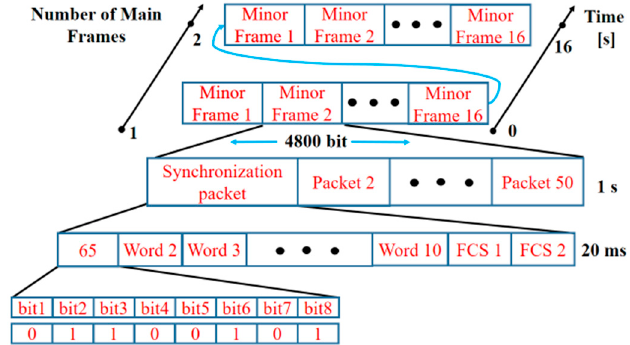
Figure 4. Orbcomm frame